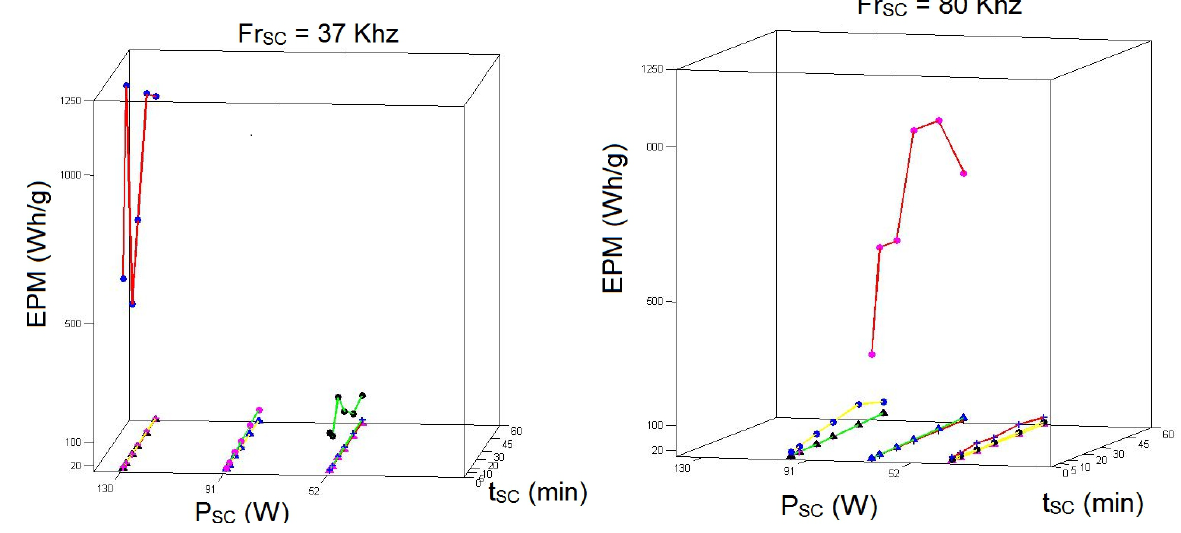
Figure 2. EPM of 18 complete runs (green line (C0=20 mg/Lit), yellow line (C0=120 mg/Lit), red line (C0=220 mg/Lit)/ circle marker (DSC=0.1 g/Lit), plus sign marker (DSC=1 g/Lit), triangle marker (DSC=1.9 g/Lit)/ black marker (pH=3), magenta marker (pH=7), and blue marker (pH=10)). the TOC received the control sample